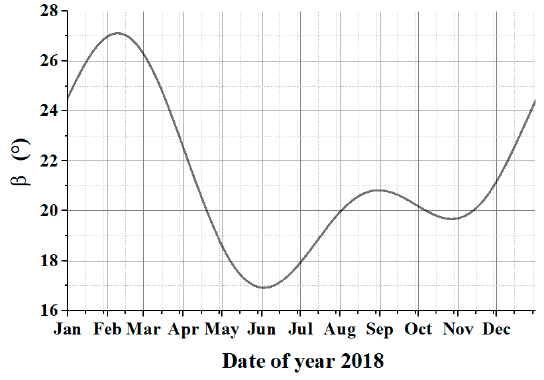
Figure 5. Angular change between solar vector and the orbit plane within a year.